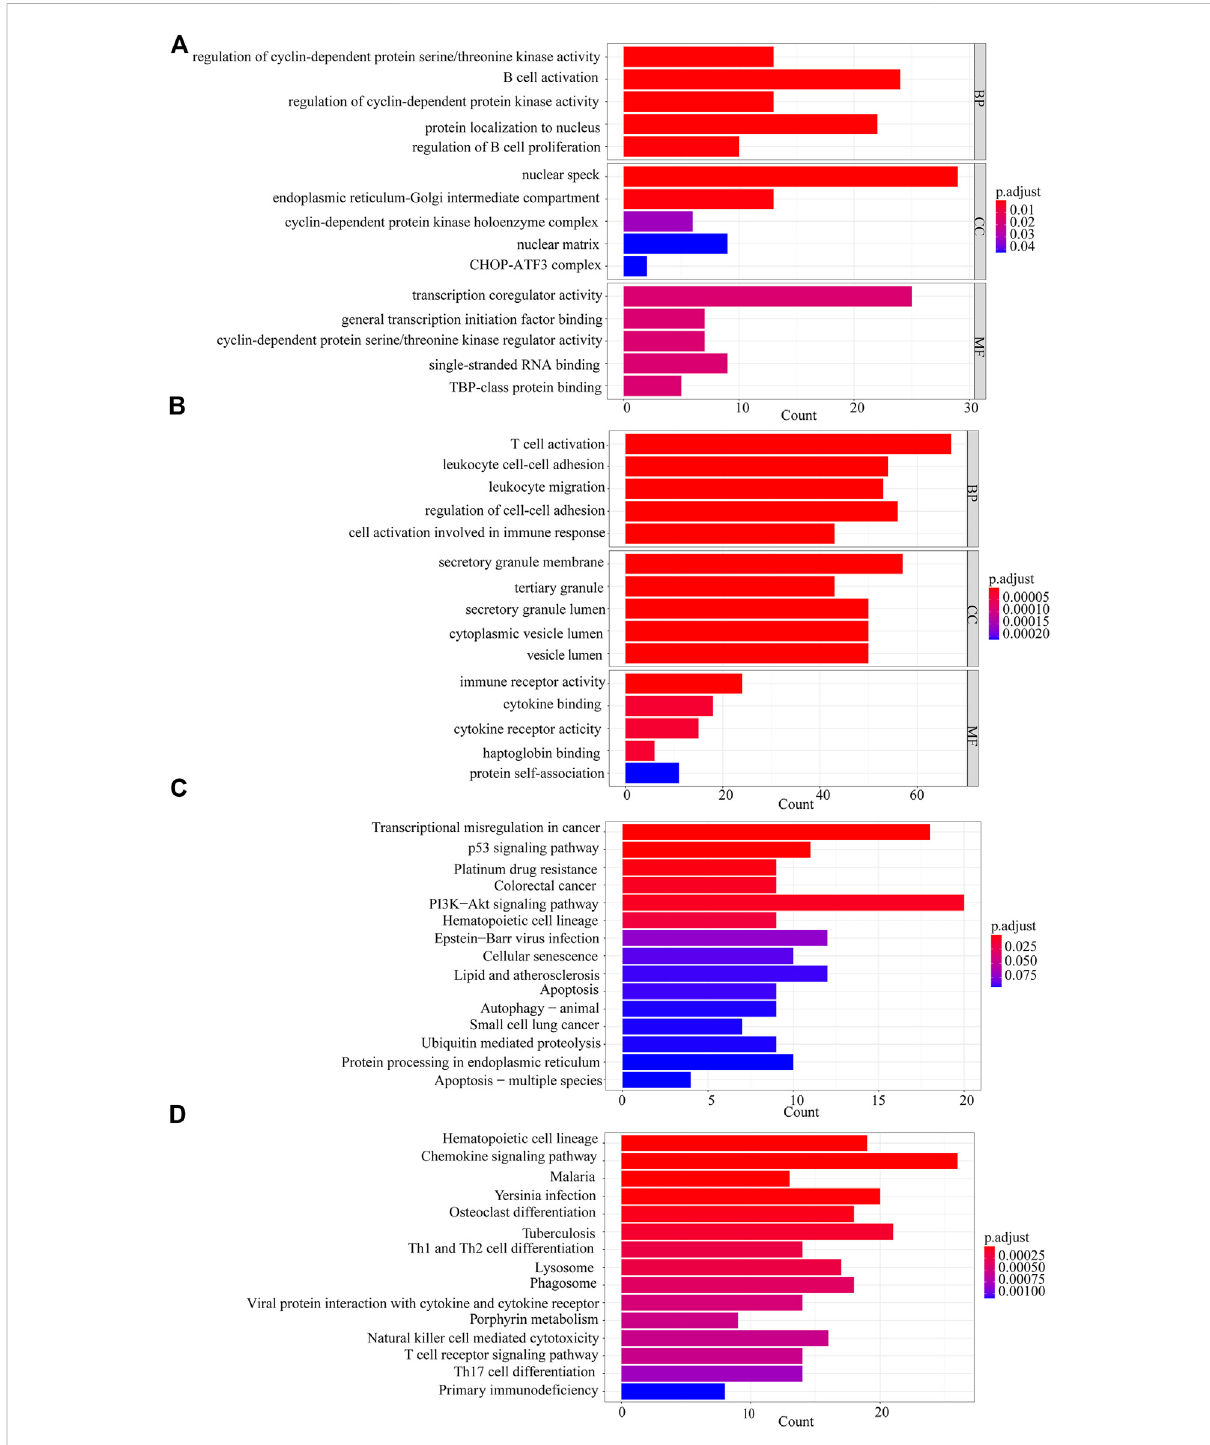
FIGURE 3 Gene Ontology (GO) enrichment and Kyoto Encyclopedia of Genes and Genomes (KEGG) pathway analyses. (A) The GO analysis of 461 up- regulated genes. (B) The GO analysis of 551 down-regulated genes. (C) KEGG analysis of 461 up-regulated genes. (D) KEGG analysis of 551 down- regulated